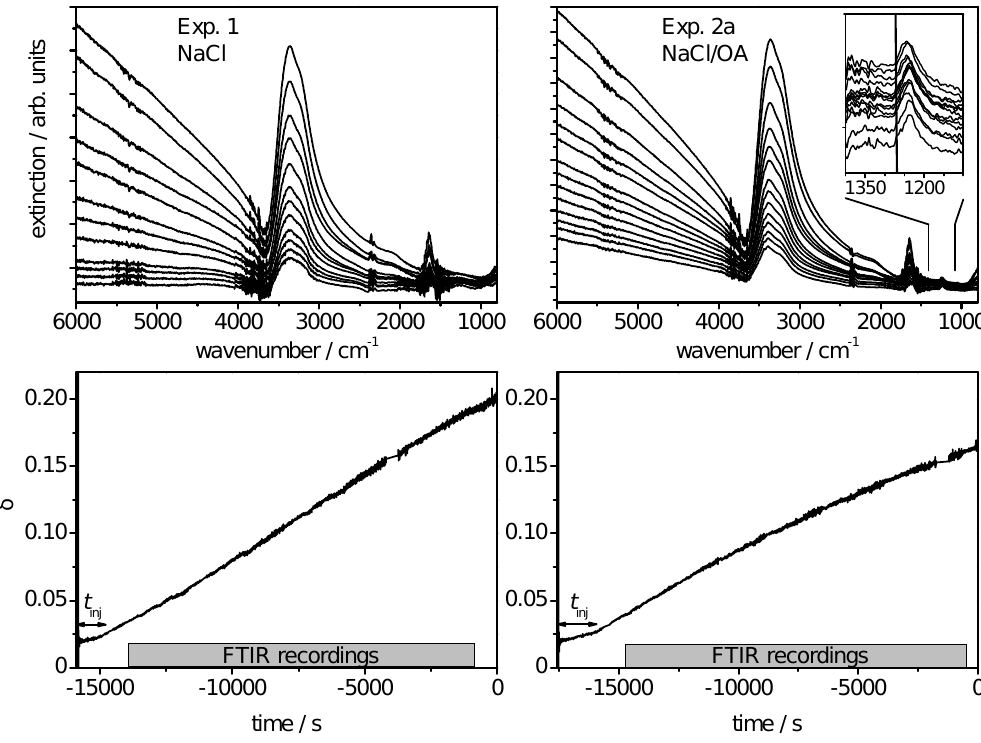
Fig. 4. Bottom panels: Time series of the backscattering linear depolarisation ratio δ after spraying aqueous solutions of 5wt% NaCl (Exp. 1, Table 1, left panel) and 5wt% NaCl+0.51wt% OA (Exp. 2a, right panel) into the AIDA chamber at 244K with an ultrasonic nebuliser. The horizontal arrows denote the overall time period of aerosol injection ( t inj ) . Time zero denotes the start of the first expansion cooling cycles that were performed later on to study the ice nucleability of the crystallised particles. The horizontal grey bars on the time scales denote the time periods of the FTIR spectra recordings that are shown in the top panels. The spectra are to be read from top to bottom and were recorded at a time interval of 20min. The inset in the top right panel shows an enlarged view in the regime of the C–O stretching mode of oxalic acid.